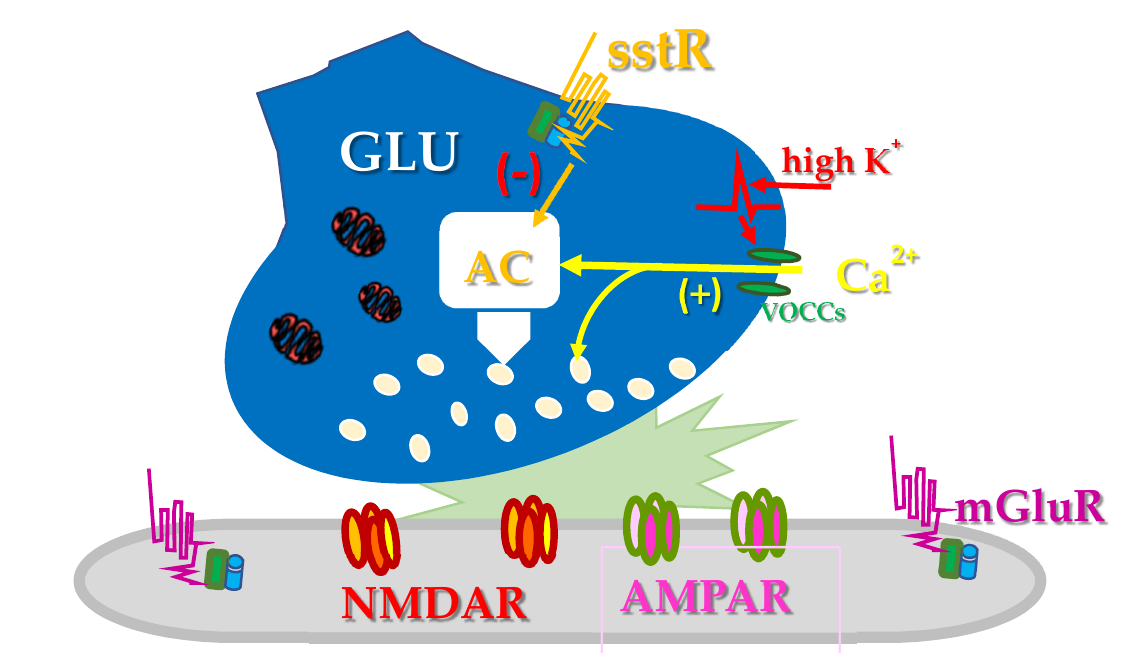
Figure 3. Depolarization with high-KCl-containing medium favours the opening of VOOCs and the influx of Ca 2+ ions that triggers glutamate exocytosis either directly through both AC/cAMP/PKA-independent and AC/cAMP/PKA-dependent pathways. Presynaptic release-regulating sst2 heteroreceptors hamper the AC/cAMP/PKA-dependent pathway, then reducing glutamate exocytosis. The sst2-mediated inhibitory effect in turn reverberates on the functions of both metabotropic (mGlu) and ionotropic (NMDA and AMPA) glutamate receptors located postsynaptically, influencing the strength of the connection at glutamatergic synapses.